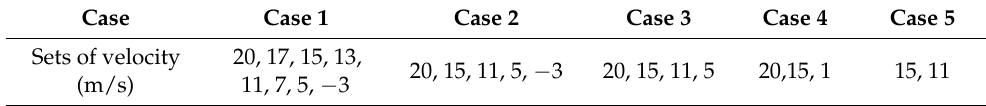
Table 3. Combination of measured responses in different cases.